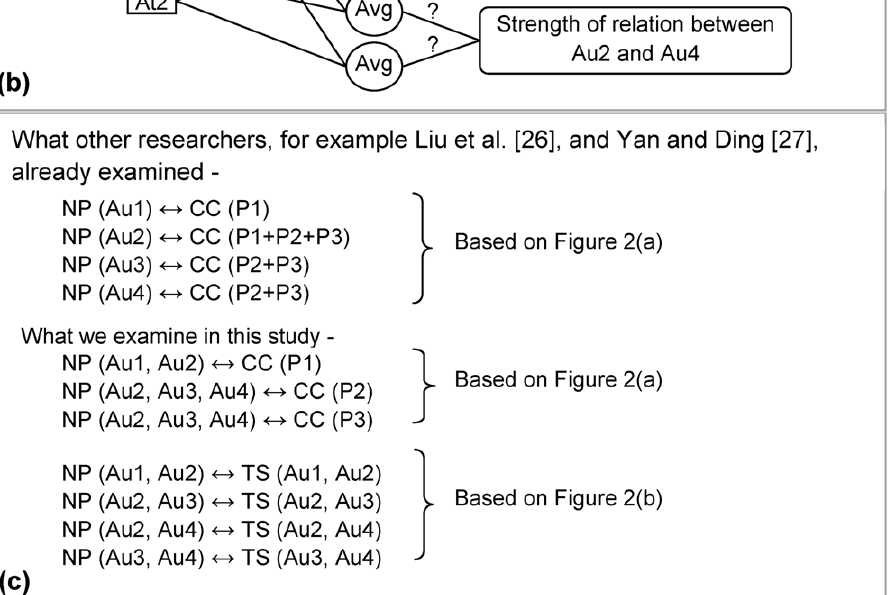
PLOS ONE | www.plosone.org 3 February 2013 | Volume 8 | Issue 2 |